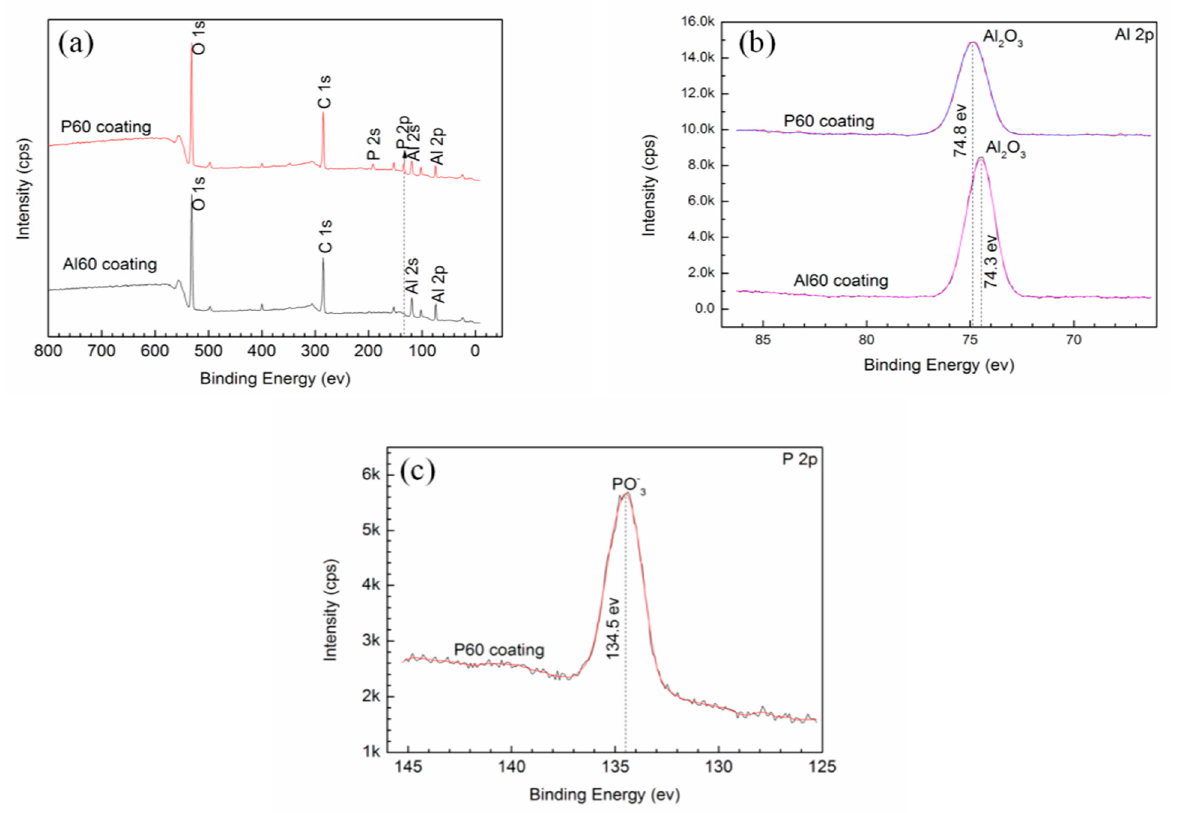
Figure 5. XPS spectra of the surface coatings prepared from different electrolytes with different treating time. ( a ) The surveys of the A60 and P60 coatings, the high-resulotion spectra of ( b ) Al 2p and ( c ) P 2p.